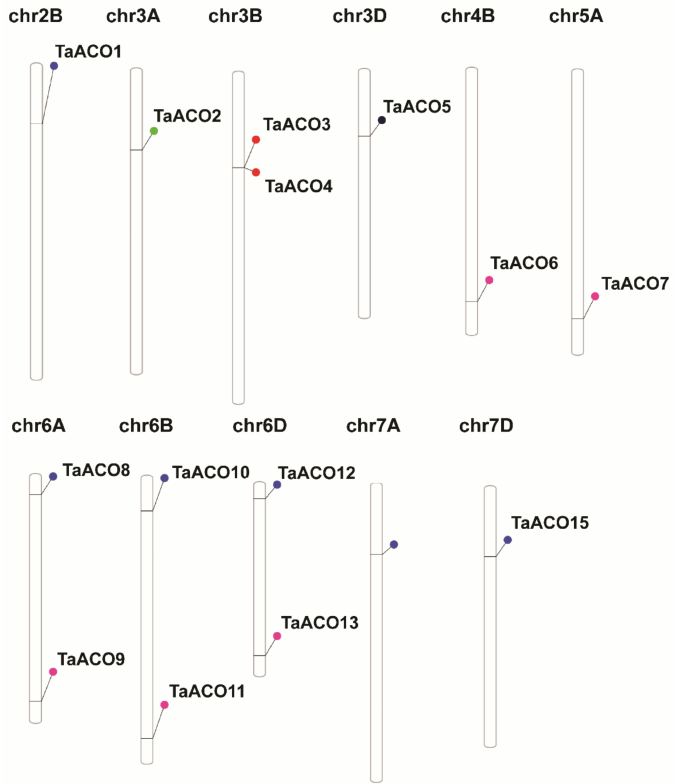
Figure 2. Chromosomal locations of identified ACO genes on the three sub-genomes of wheat. Schematic chromosomal location of ACO genes on the different chromosomes, whereas gene name is mentioned on the right side. The different colored sphere indicates the position of the ACO genes on the wheat chromosomes. The chromosome numbers are shown above the chromosomes.